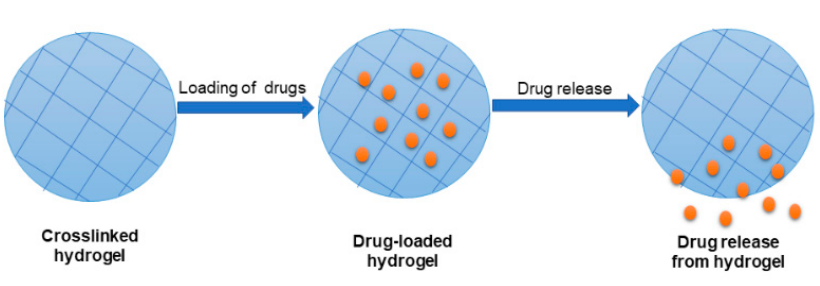
Figure 3. Schematic diagram of hydrogels.